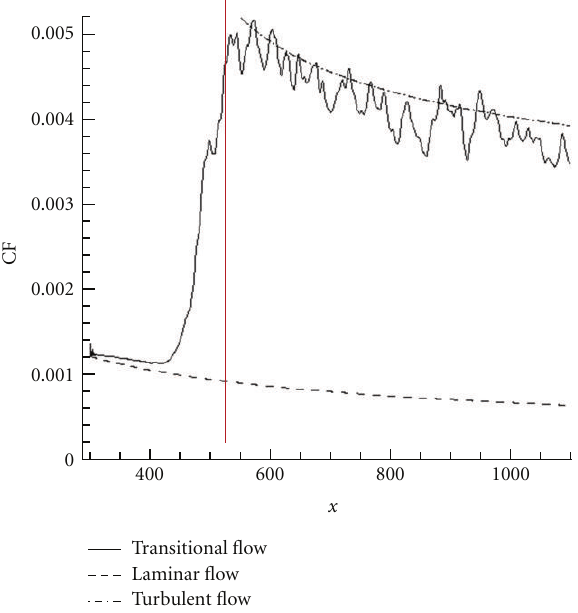
Figure 34: Maximum CF at x = 508 . 633